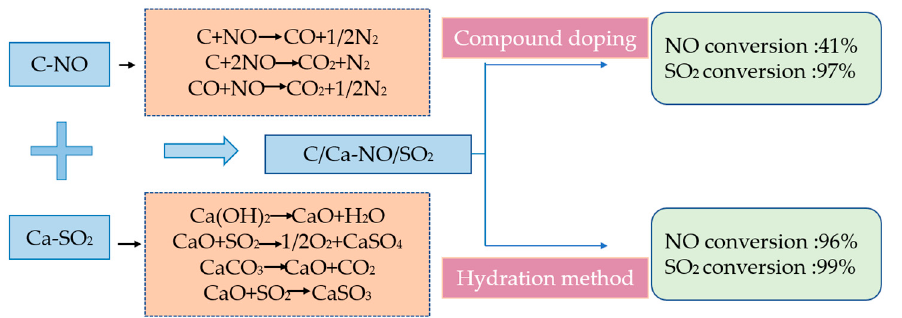
Figure 8. Mechanism of flue gas desulfurization and denitrification in cement kiln based on C–CaO–SiO 2 coupling enhancement effect.